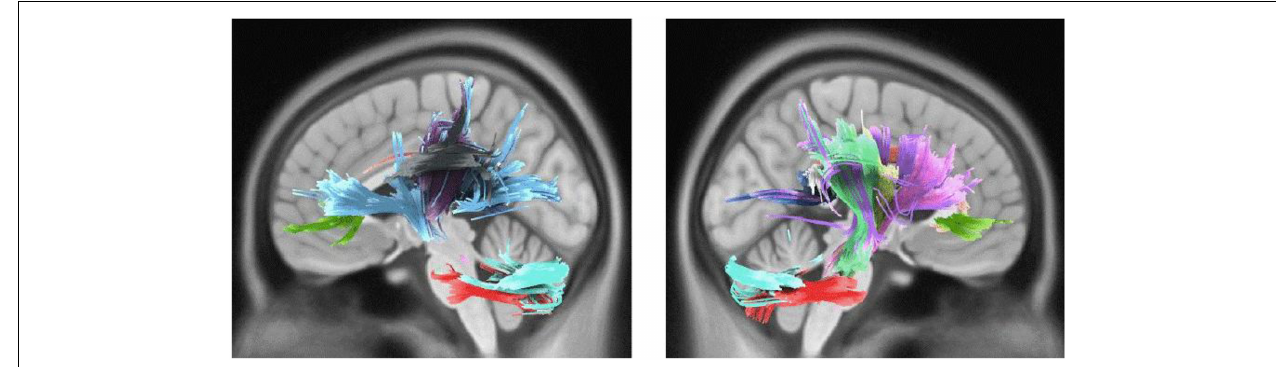
FIGURE 1 | White matter pathways with significantly positive association with Active engagement in male participants (FDR = 0.008).